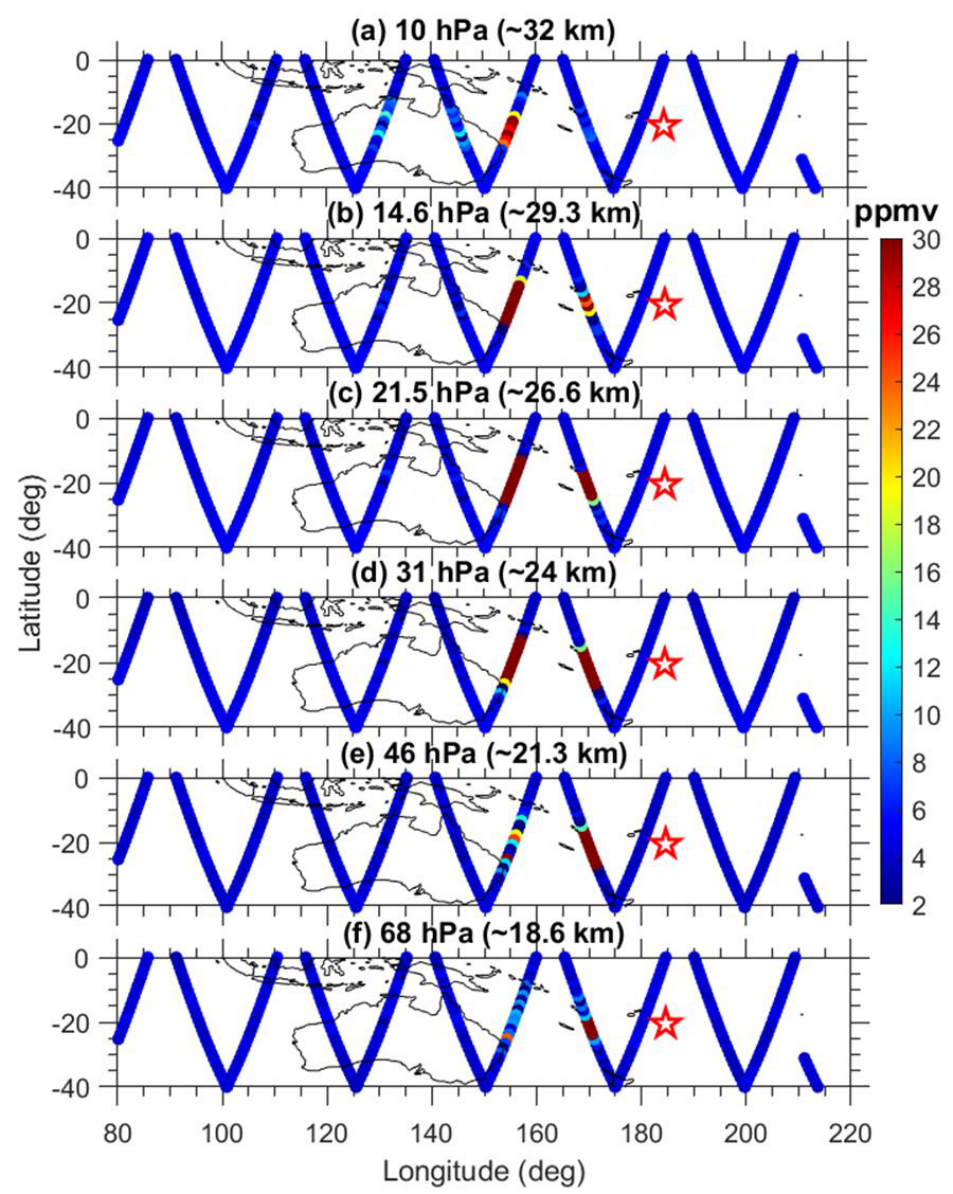
Figure 5. Map of water vapor mixing ratio at different levels from the Microwave Limb Sounder (MLS) measurements, observed at two local times, 12 h apart, on 16 January 2022. Mid – afternoon sampling runs southeast to northwest, while nighttime observations run northeast to southwest. The red – colored pentagram represents the location of the Tonga volcano.